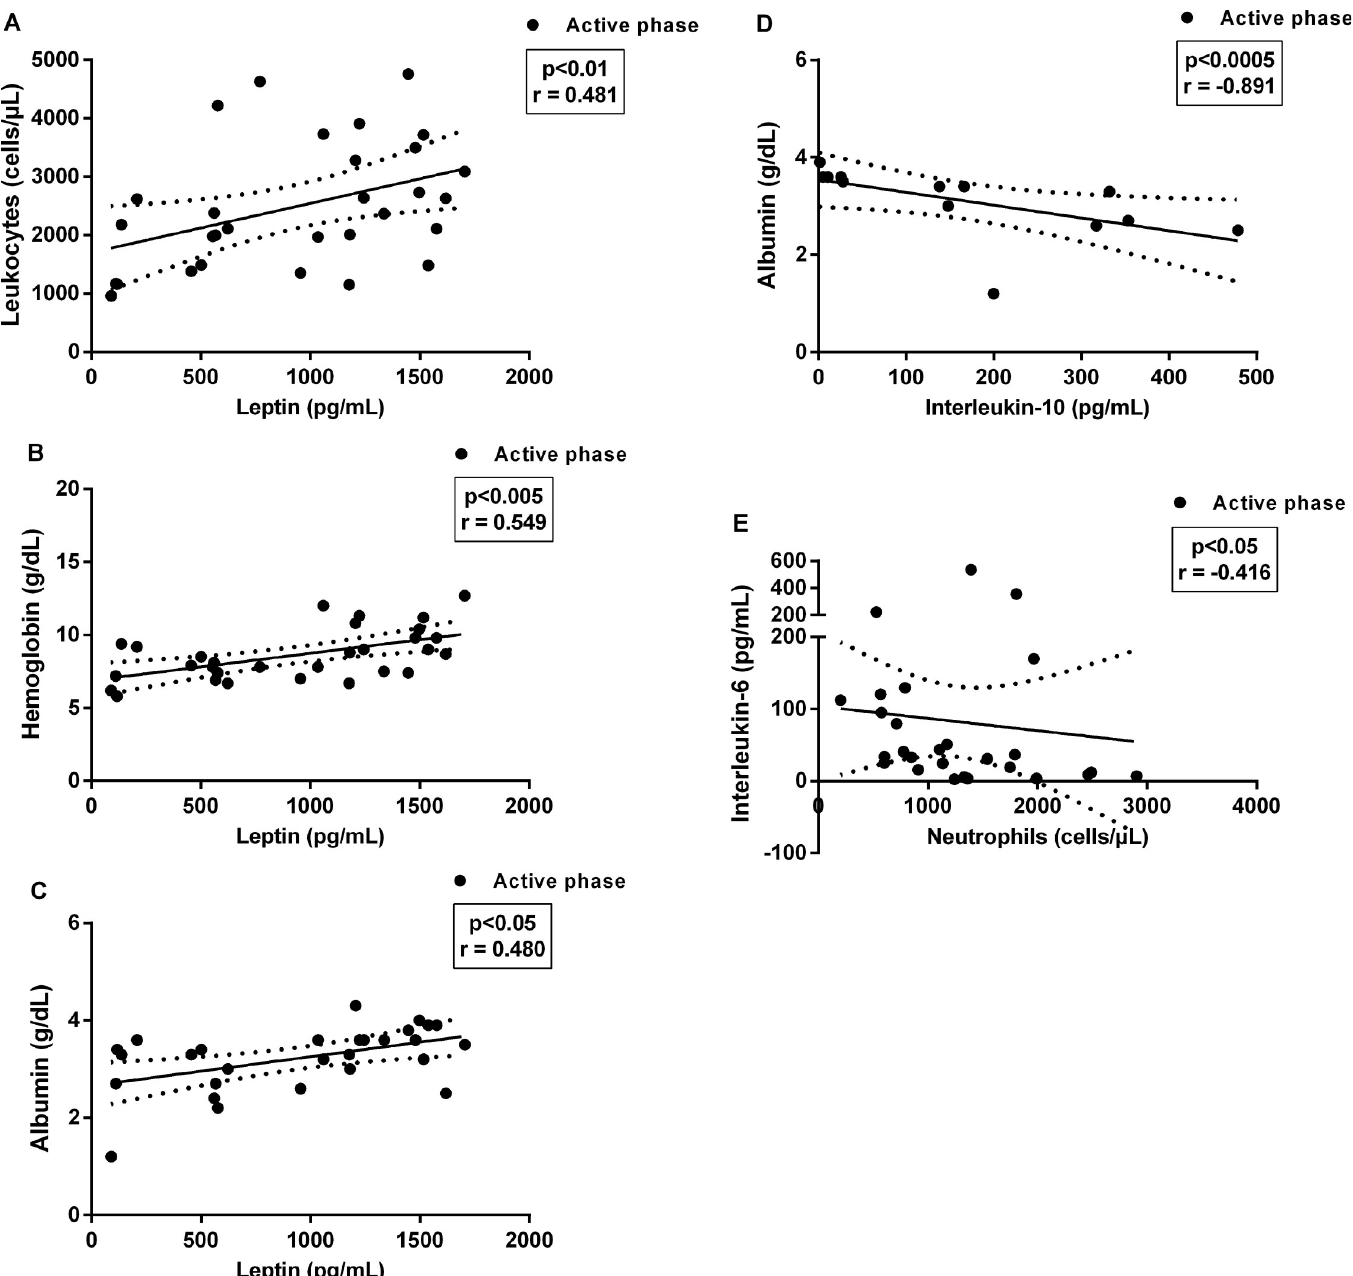
Fig 5. Correlations between laboratorial biomarkers of severity and leptin and cytokine levels in visceral leishmaniasis (VL) patients during active phase. Positive correlations between the leptin levels and (A) leukocytes, (B) hemoglobin and (C) albumin levels of the VL patients in the active phase of disease. Negative correlations between IL-10 and IL-6 levels and albumin and neutrophils levels (D and E, respectively) . Each symbol represents one patient in the active phase of VL. Spearman correlation. p < 0.05, p < 0.01, p < 0.005.